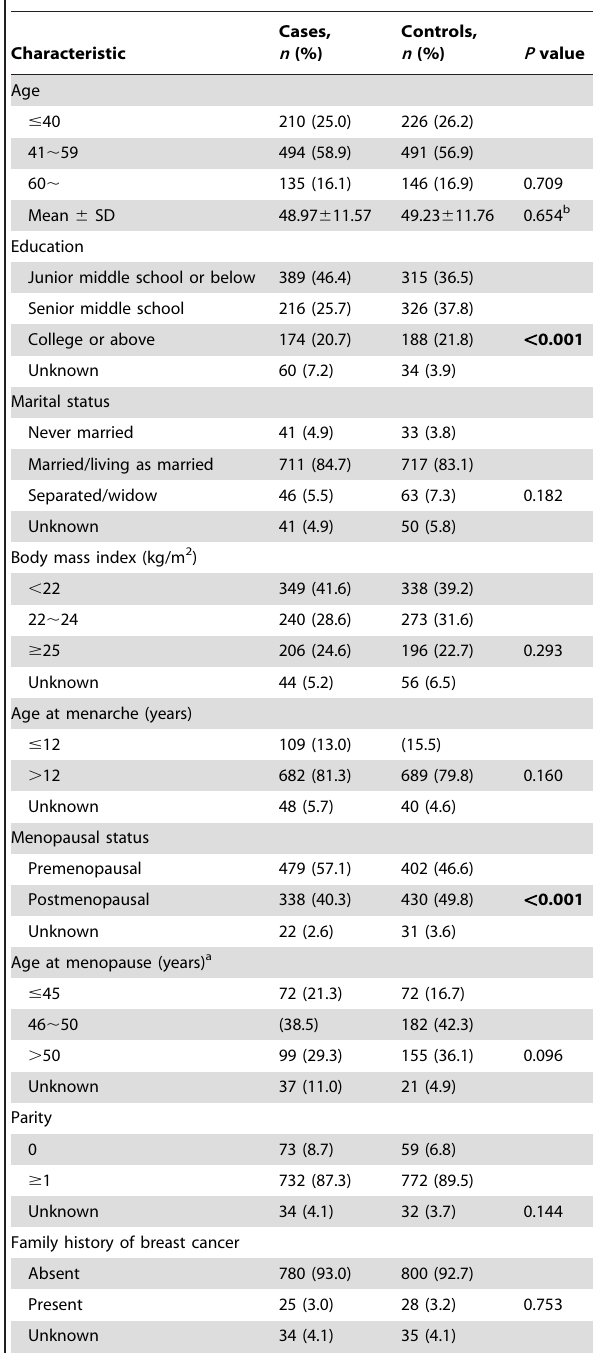
Table 1. Characteristics of breast cancer cases and